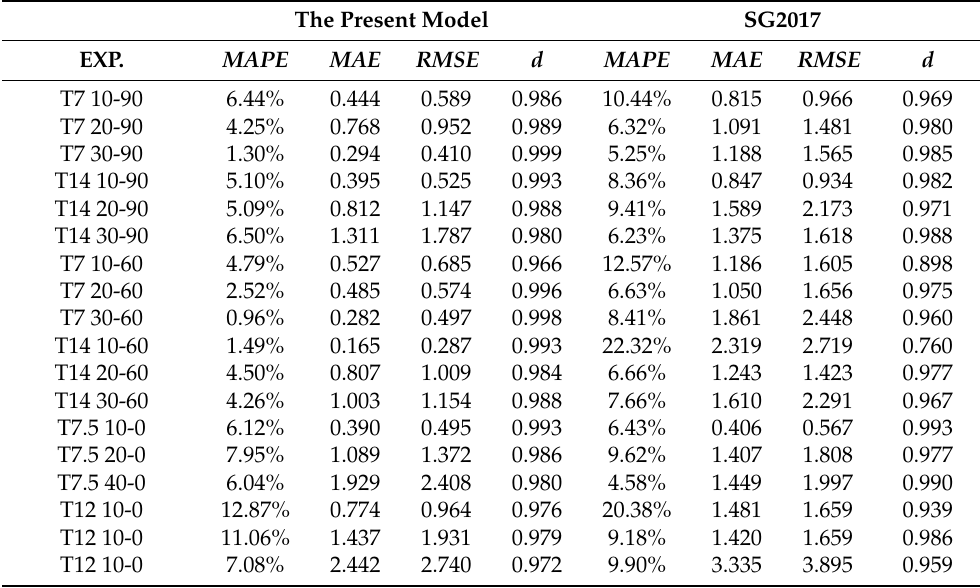
Table 4. Comparison of accuracy of the present model and the SG2017 model in calculating current